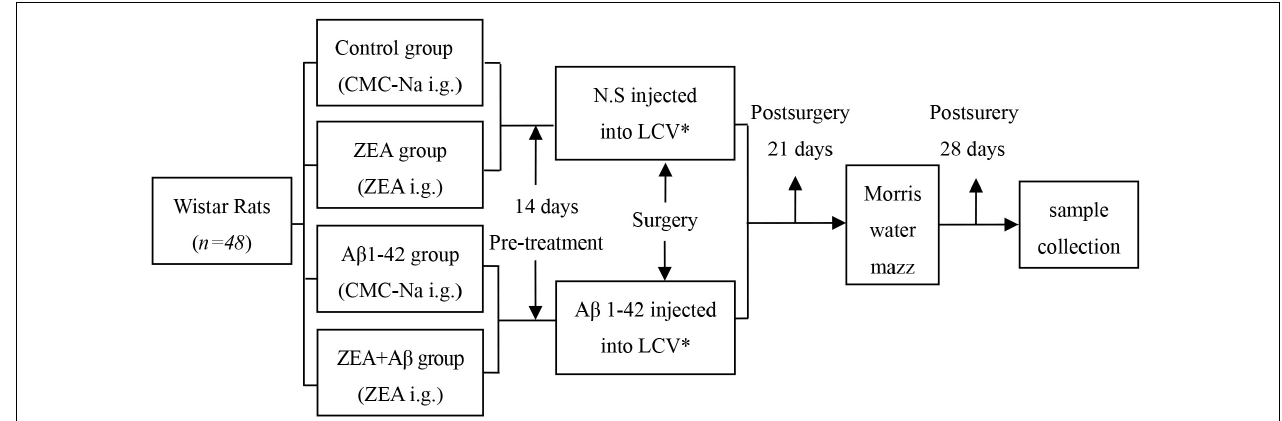
FIGURE 1 | The schedule of the rat’s experiment. ∗ LCV is lateral cerebral ventricle.